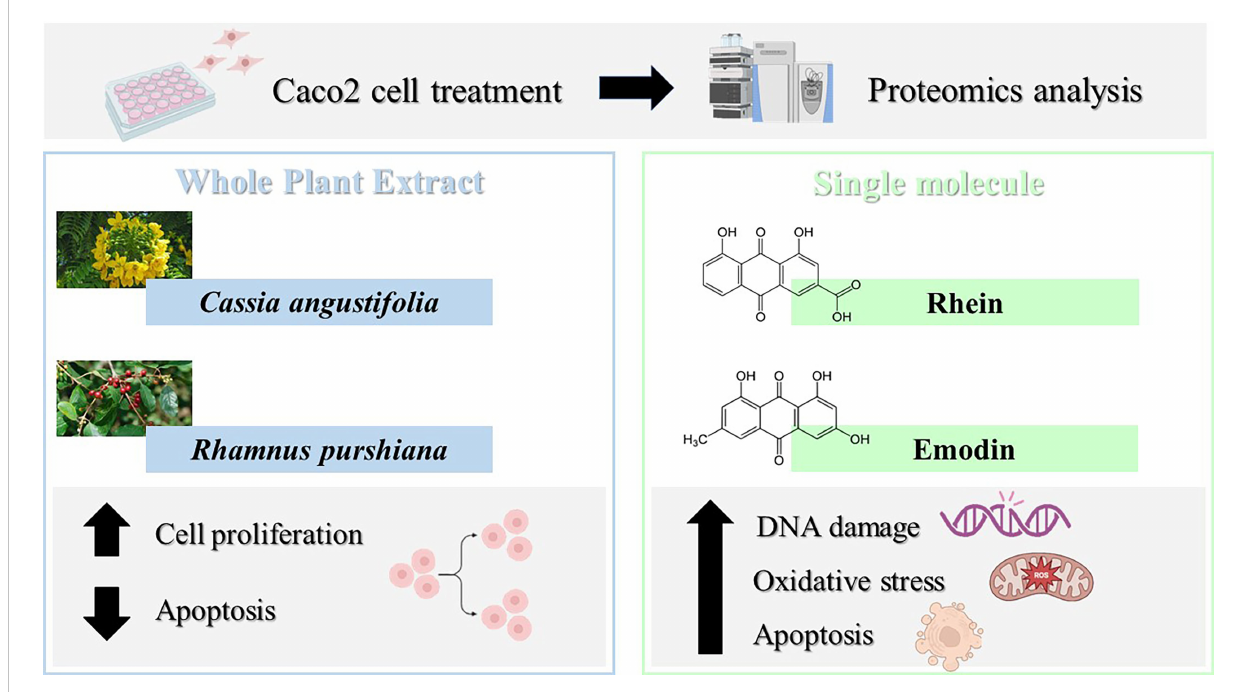
FIGURE 8 Caco-2 cell proteomics with different treatments (single molecule and phytocomplex) leads to the activation of different biological